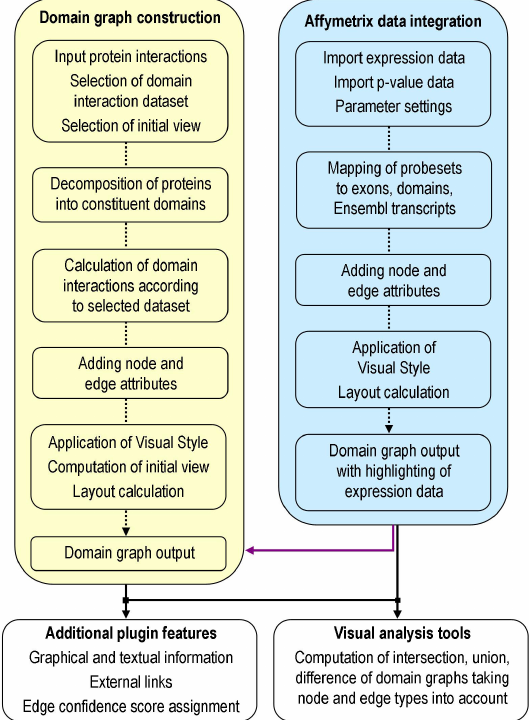
Figure 9: Schema of the domain graph construction and the A ff ymetrix expression data integra- tion. The plugin features and analysis methods can both be applied to domain graphs with and without expression data as shown by the black arrows at the bottom. The purple line indicates that the second module can optionally be applied to a constructed domain